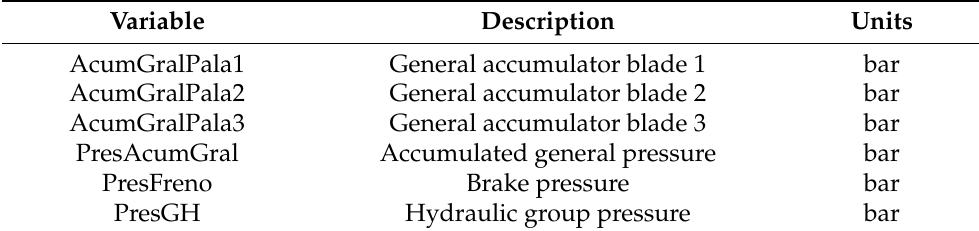
Table 5. Hydraulic